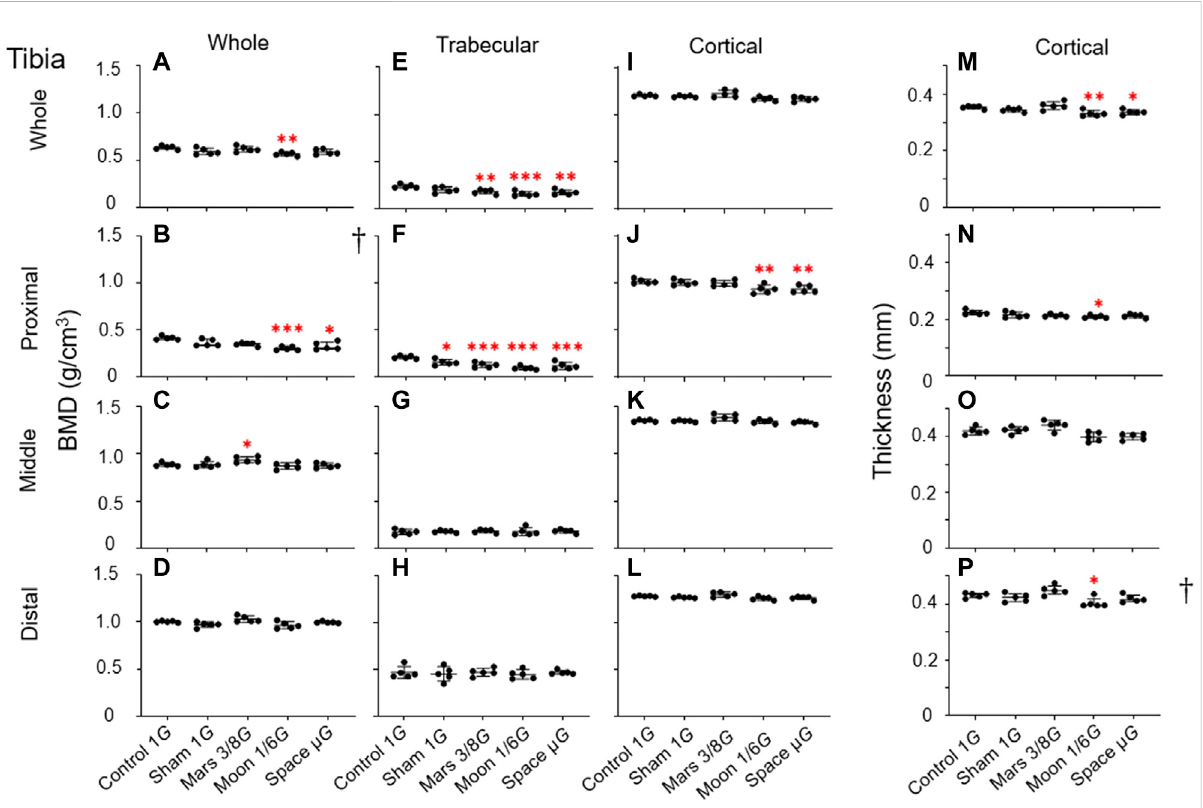
FIGURE 6 Bone parameters of various tibial regions compared among the fi ve experimental groups. (A – D) Overall BMD, (E – H) trabecular BMD, (I – L) cortical BMD, and (M – P) cortical bone thickness. (A,E,I,M) Whole tibia, (B,F,J,N) proximal tibia, (C,G,K,O) middle tibia, and (D,H,L,P) distal tibia [Mean ± SD, one-way analysis of variance; † M (P25, P75), kruskal-wallis test, n = 5. * p < 0.05 vs. control group, ** p < 0.01 vs. control group, *** p < 0.001 vs. control